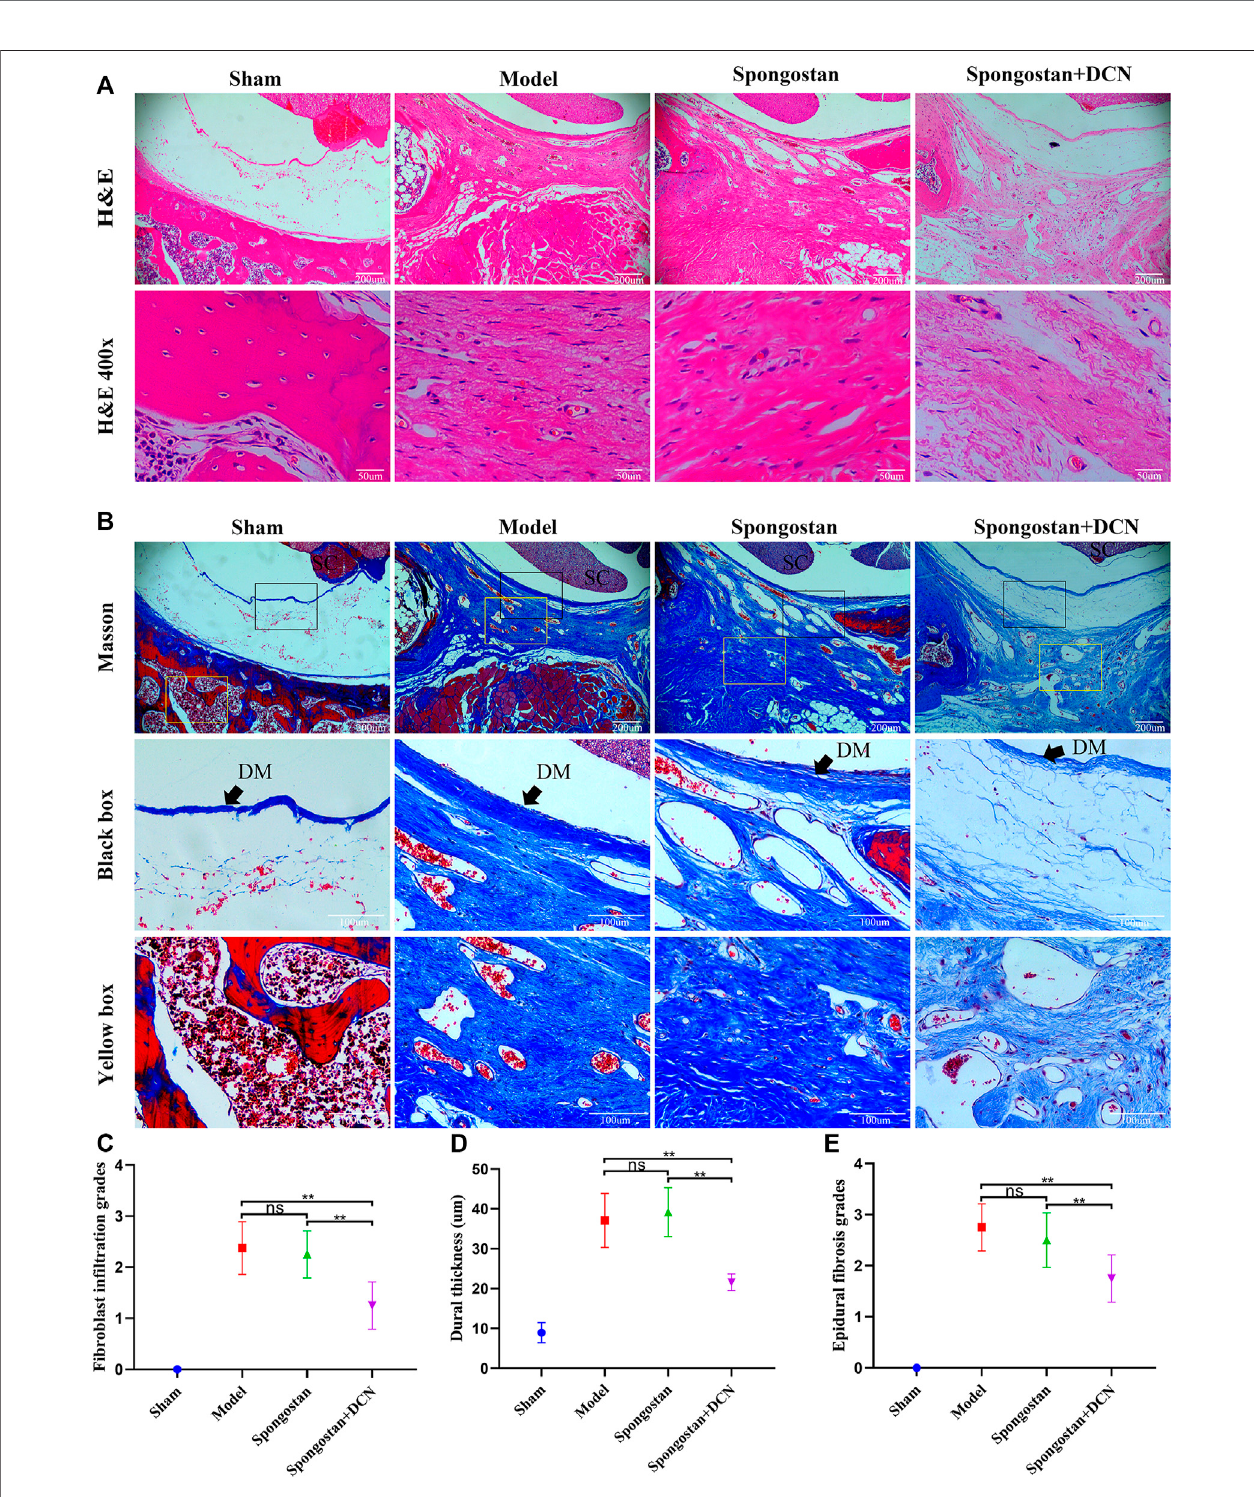
FIGURE9| RepresentativeH&EstainingandMassonstainingfromeachgroupat8 weekspostoperatively. (A) H&Estainingofspinalcolumninlaminectomysites. The high-resolution images (400 × ) in the bottom panel show fi broblast in fi ltration. (B) Masson-stained sections of laminectomy sites. DM, dura mater; SC, spinal cord. (C) Quanti fi ed fi broblastin fi ltrationgradesathighresolution(400 × ). (D) Comparisonofduralthicknessamonggroups. (E) Quantitativeanalysisofepidural fi brosisgrades according to Masson-stained sections. * p < 0.05; ** p < 0.01.